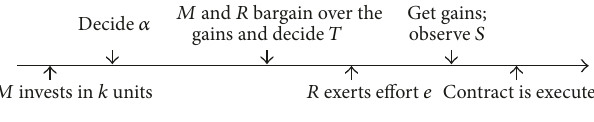
Figure 1: Timeline of events.